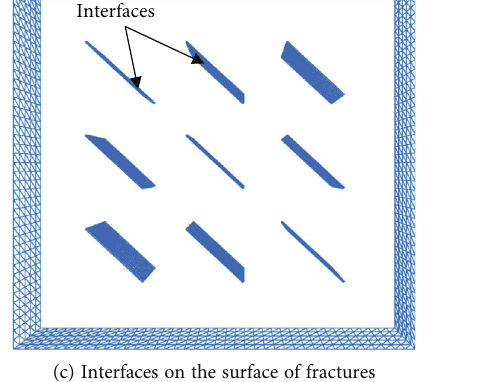
Figure 4: Numerical model of PFN-containing rock mass.